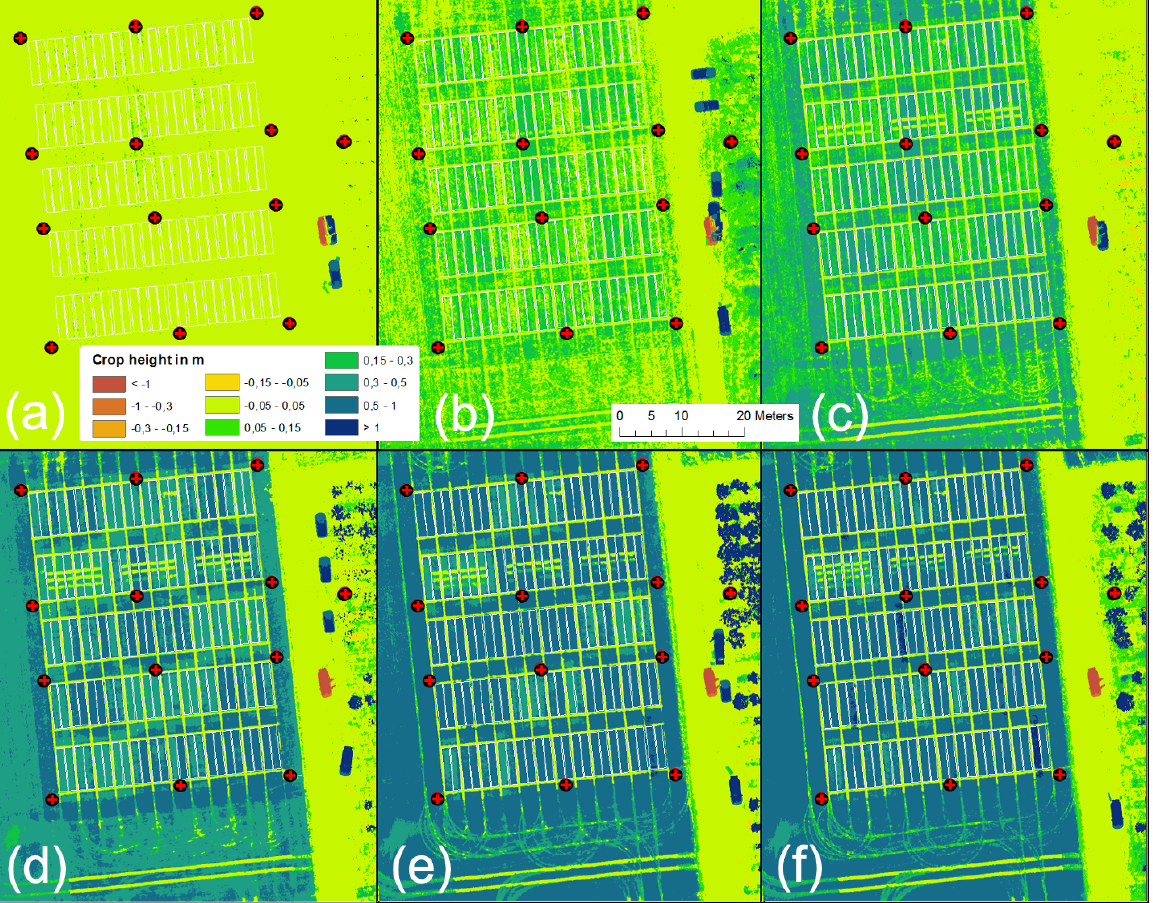
Figure 10. UAV-derived development of crop height in meters over the growing season 2020 for ( a ) 7 April , ( b ) 28 April, ( c ) 13 May, ( d ) 26 May, ( e ) 12 June, and ( f ) 1